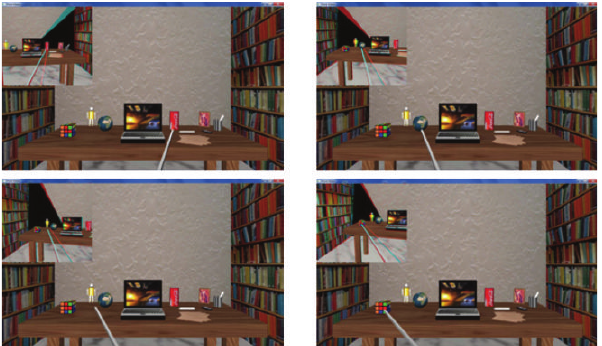
Figure 8: Snapshots of the performance of the virtual developed environment, obtained when the interocular distance between the two stereoscopic vergent cameras is set to 6.5